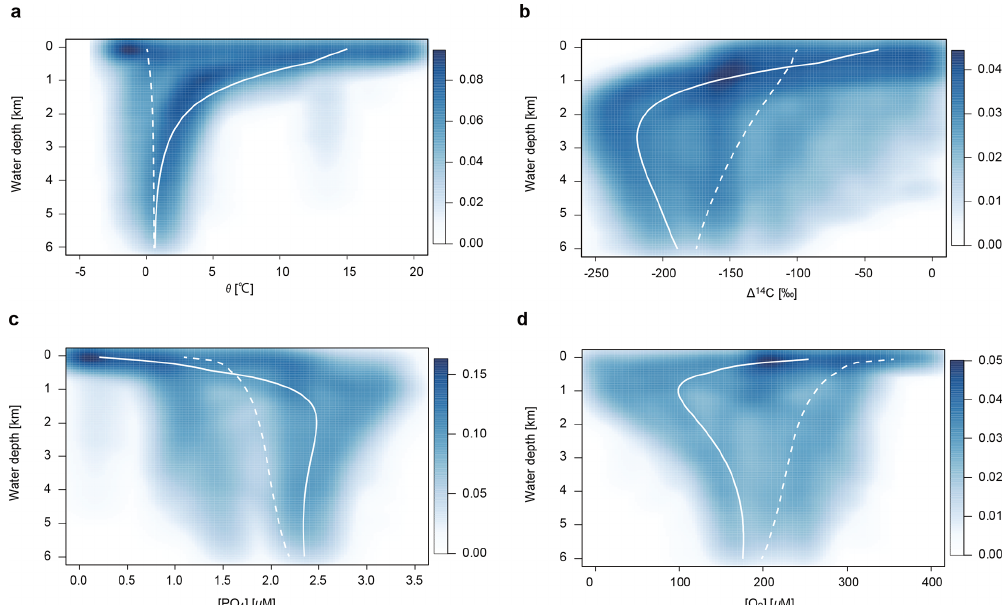
Figure 11. Simulated steady-state depth profiles of (a) potential temperature, θ , (b) radiocarbon, (cid:49) 14 C, (c) DIP (dissolved inorganic phos- phorus, PO 3 − ), and (d) dissolved oxygen, O 2 . Solid and dashed white lines denote the simulated profiles for the LD and HD regions, 4 respectively. Simulation results are compared with the dataset from the Global Ocean Data Analysis Project (GLODAP) database (GLO- DAPv2_2019; Key et al., 2015; Olsen et al., 2016). The color represents the density of observational